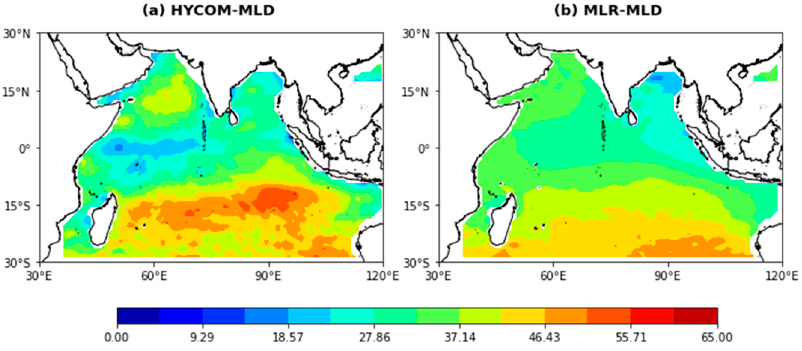
Figure 9. Average annual MLD in the Indian Ocean estimated from ( a ) the HYCOM and ( b ) the MLR model in 2019.